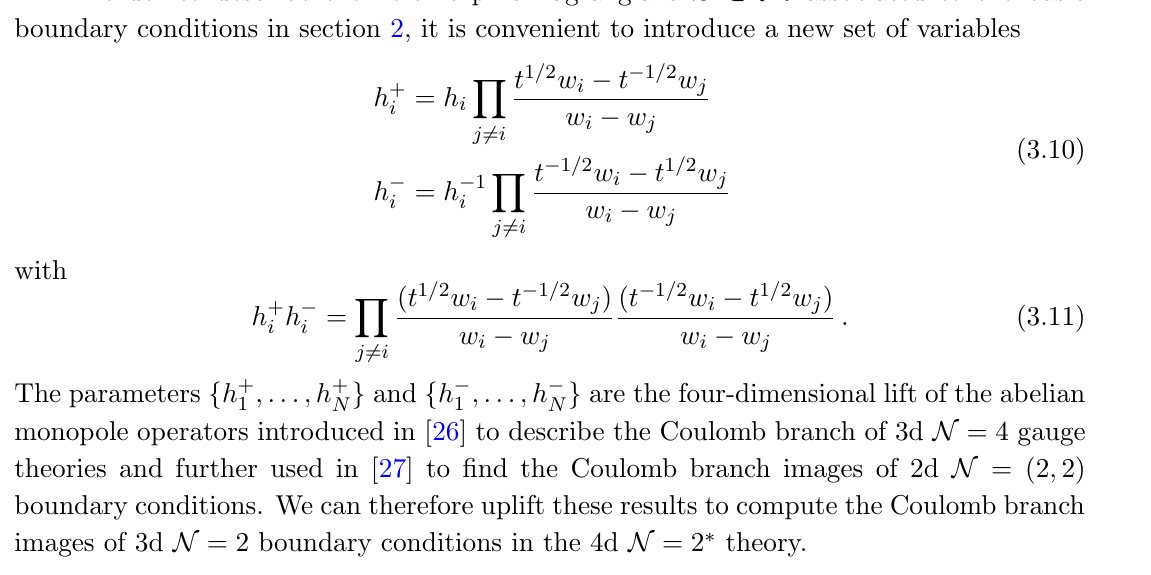
3 with defect of monodromy eigenvalues f t (cid:0) p f g